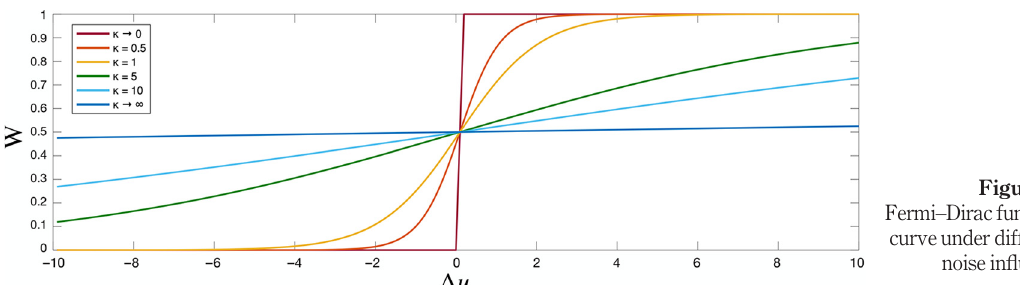
Figure 2. Traversal all possible crowd intelligence interactions and formulae that contain three intelligent individuals